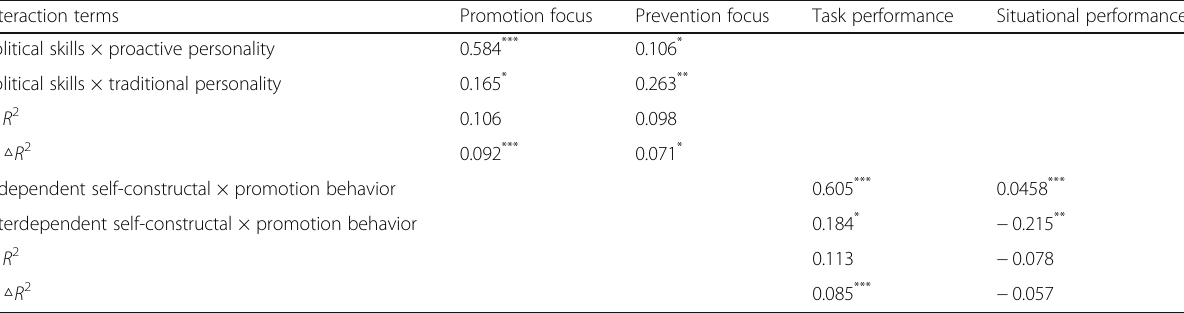
Table 4 Moderation effects of political skills and self-constructal